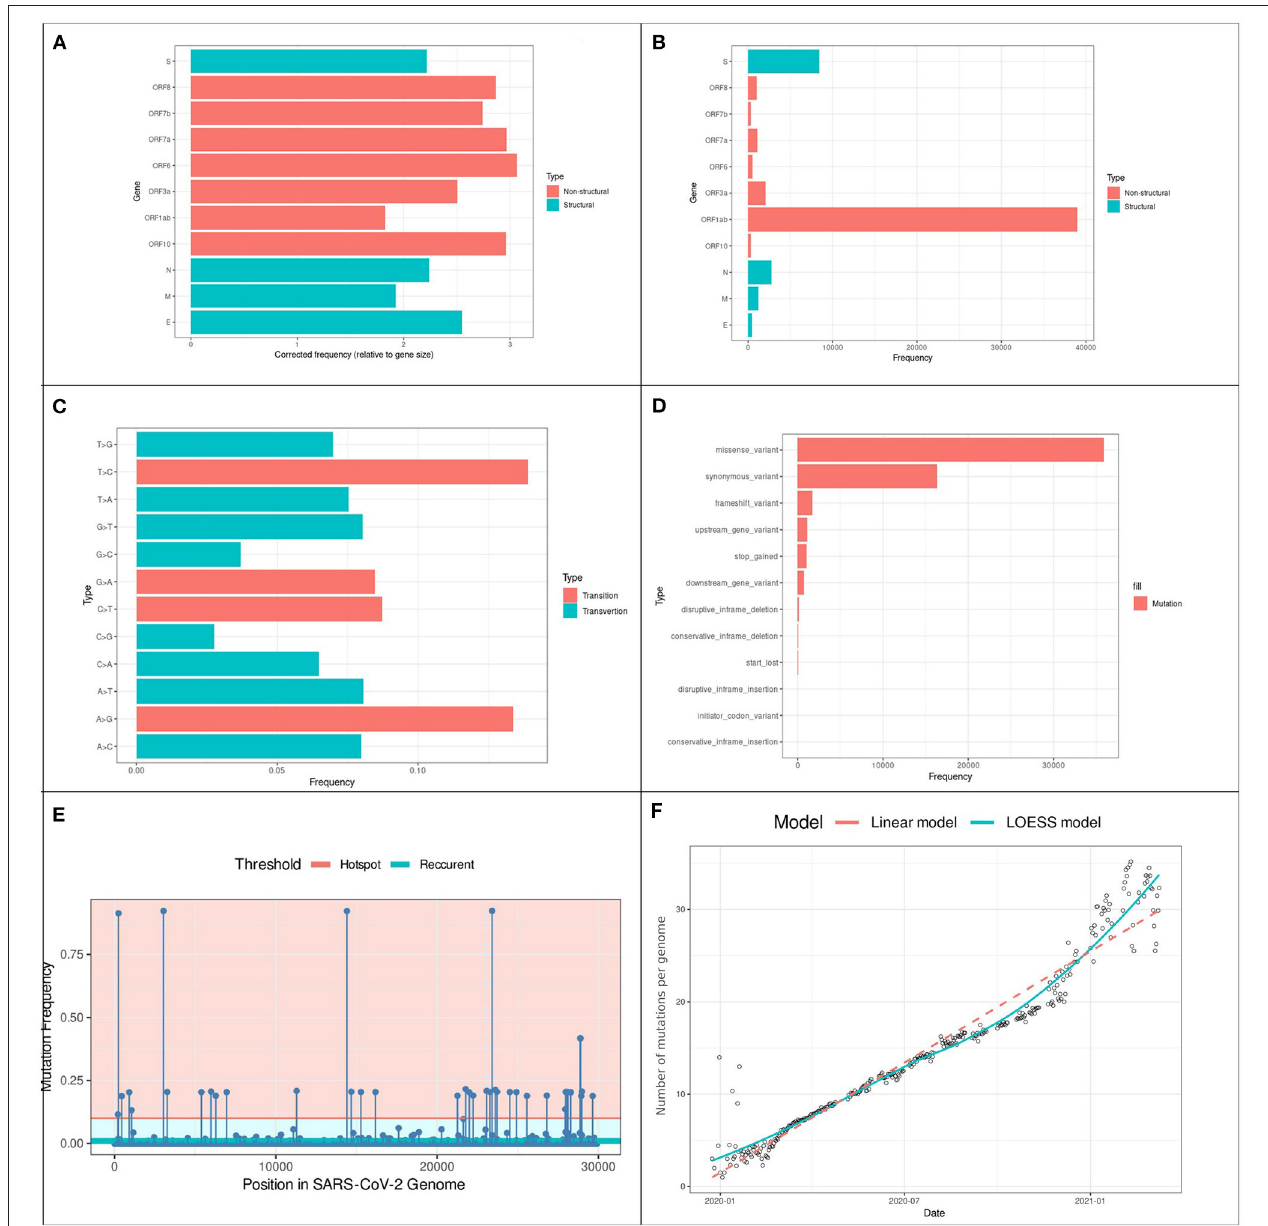
FIGURE 2 | Prevalence and distribution of types of variants in 201,951 SARS-CoV-2 genomes (A) variants locations: the y-axis represents the gene location of variants, and the x-axis the rate of each gene. (B) Gene length corrected frequency (C) variants type frequencies: the y-axis represents the type of variants, and the x-axis the rate of each variation. (D) Types frequency: The prevalence of each type of variation: the y-axis represents the type of variant, and the x-axis the rate of each type. (E) Distribution of the 36,967 variants across the SARS-CoV-2 genome. The Lollipop plot illustrates the location of variations. The horizontal lines represent the threshold for recurrent (light-blue) and hotspot (Red) variations. All types of variations are included (non-synonymous, synonymous, and intergenic). Forty two (hotspot) variations occurred in more than 10% of analyzed genomes from which 241C > T, 3037C > T, 14408C > T and 23403A > G were identified in more than 91% (N ≧ 184525). (F) Variations accumulative on SARS-CoV-2 genomes over 16 months. Points on the scatter-plot represent genomes, the x-axis represents the collection date and y-axis is the number of variations. Linear (red) and Local Polynomial (light-blue) regression models are plotted to visualize the trend of evolution over the past 16 months of the